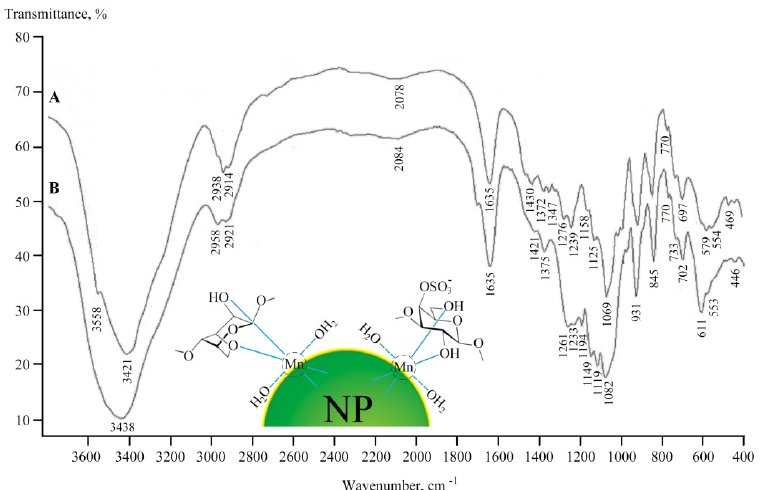
Figure 5. FTIR spectra of original polysaccharide κ -CG ( A ) and NC κ -CG-Mn ( B ).